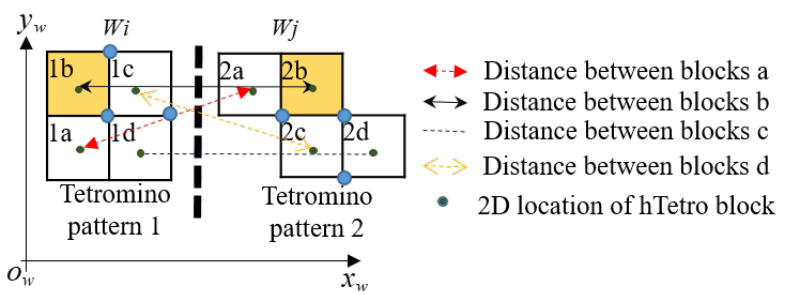
Figure 10. Finding block location for the symmetrical morphology